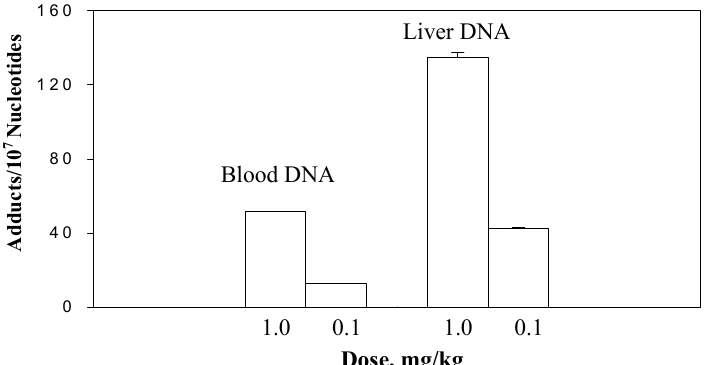
Figure 3. The dose-responsible formation of the DHP-derived DNA adducts in the blood and liver DNA samples of rats treated with riddelliine at the doses of 1.0 and 0.1 mg/kg/day. Blood samples were collected from 3 rats per group and combined within the group. Data from liver DNA samples were the mean ± SD (n = 3). DHP-derived DNA adducts were assayed by the 32 P-postlabeling/HPLC method as described in the Method